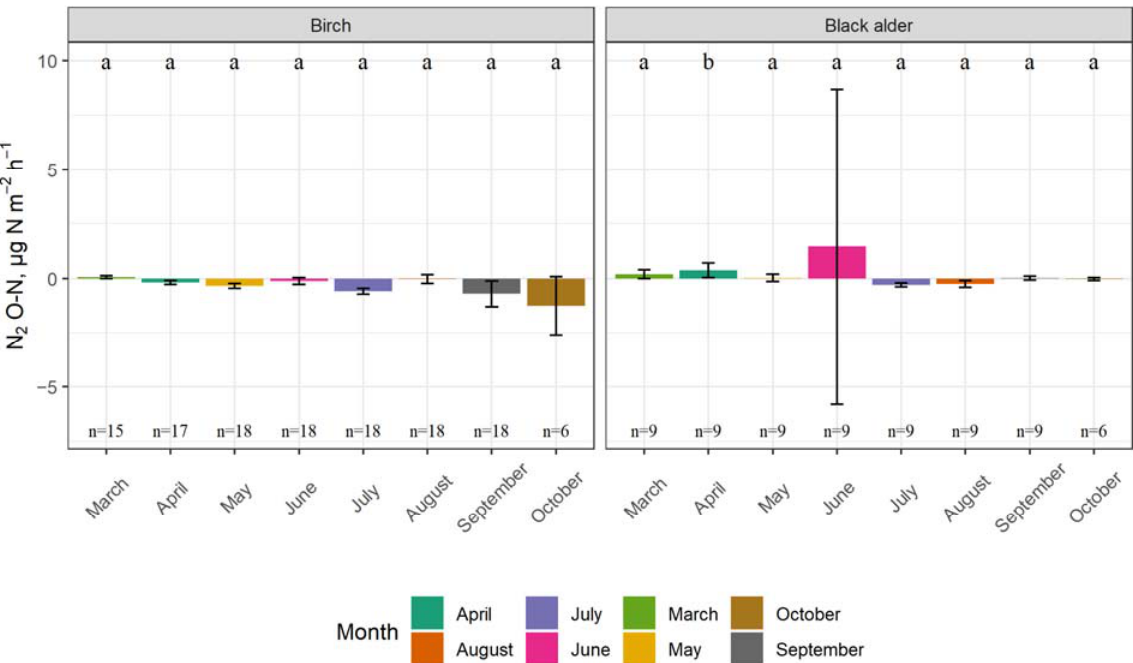
Figure 6. Average monthly N 2 O fluxes and removals from silver birch and black alder stems (mean value ± S.E.). Numbers below the bars (n) show number of measurements in each month. Negative values indicate N 2 O removals by tree stems. Different lowercase letters show statistically significant differences ( p < 0.05, Wilcoxon rank sum exact test) between tree species within the same month.